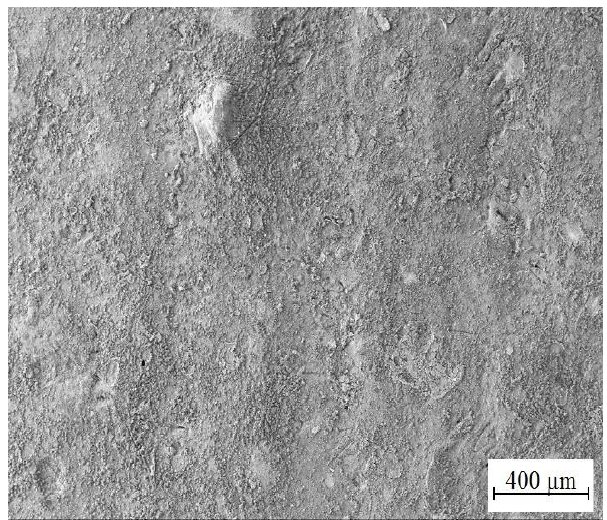
Figure 23. Morphology of precipitated corrosion products on the surface of HDG sample after ex- posure (3 months) in model concrete pore solution with addition of KMnO 4 − (solution Mn (3) ). exposure (3 months) in model concrete pore solution with addition of KMnO